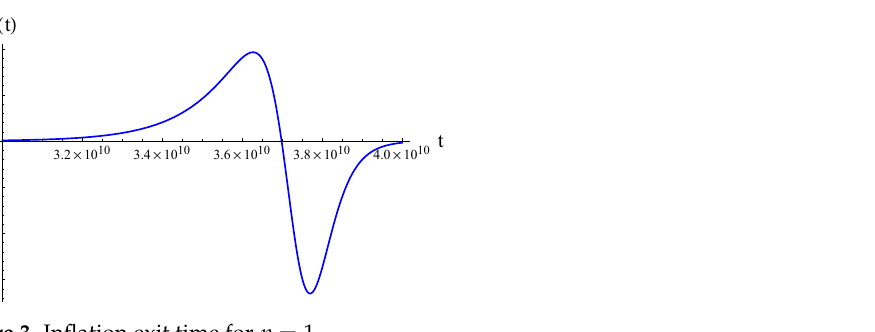
Figure 3. Inflation exit time for p = 1.